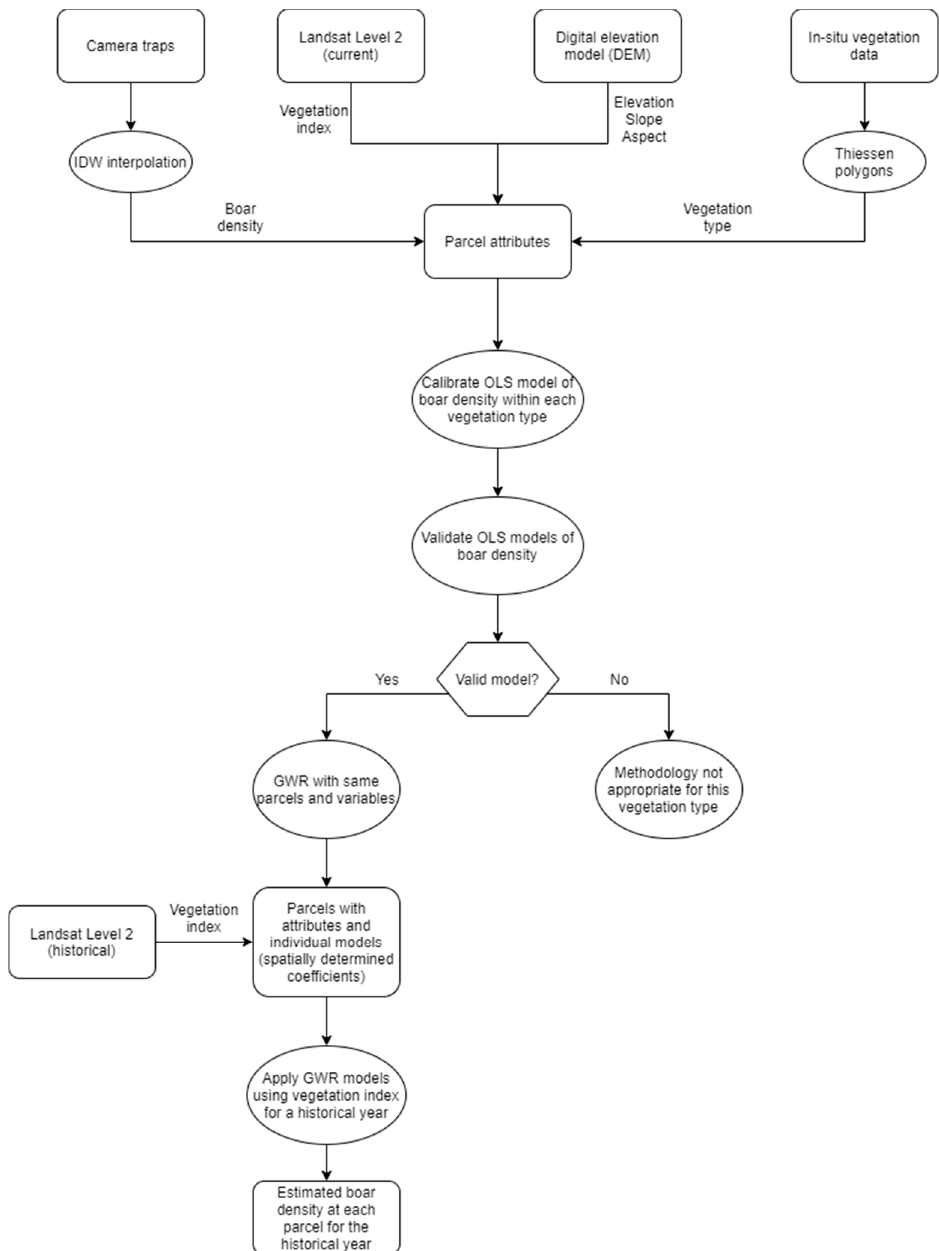
Figure 4. Methodological framework for estimating boar density across years.